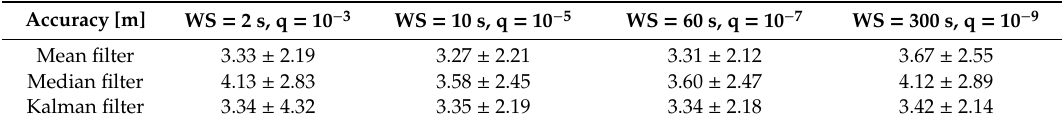
Table 1. Average tag localization accuracy calculated for RSS filtered by different filters (mean ± STD) with a different window size (WS) and coefficient q for the Kalman filter.